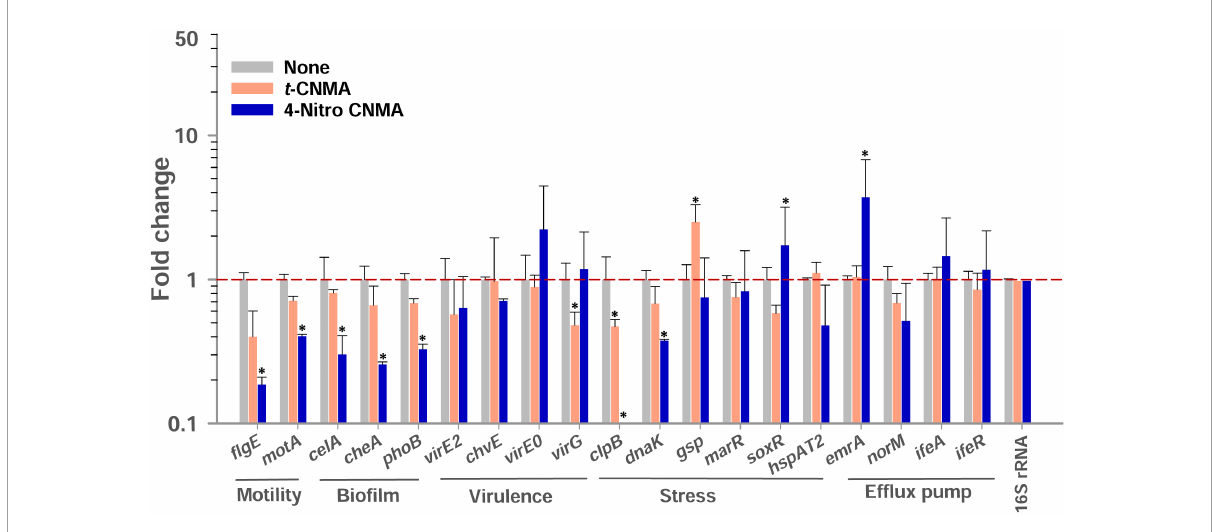
FIGURE8 Gene expressional changes in A. tumefaciens induced by 100 µ g/ml t -CNMA or 4-nitro CNMA after treatment in LB broth at 250 rpm for 8 h at 30 ◦ C. Bars are averages of four reactions performed using two independent cultures. 16S rRNA was used as the housekeeping gene. “*” represents a significant difference ( P ≤ 0.05) between non-treated and treated cells. Fold changes in gene expression were calculated using the 2 − (cid:49)(cid:49) Ct